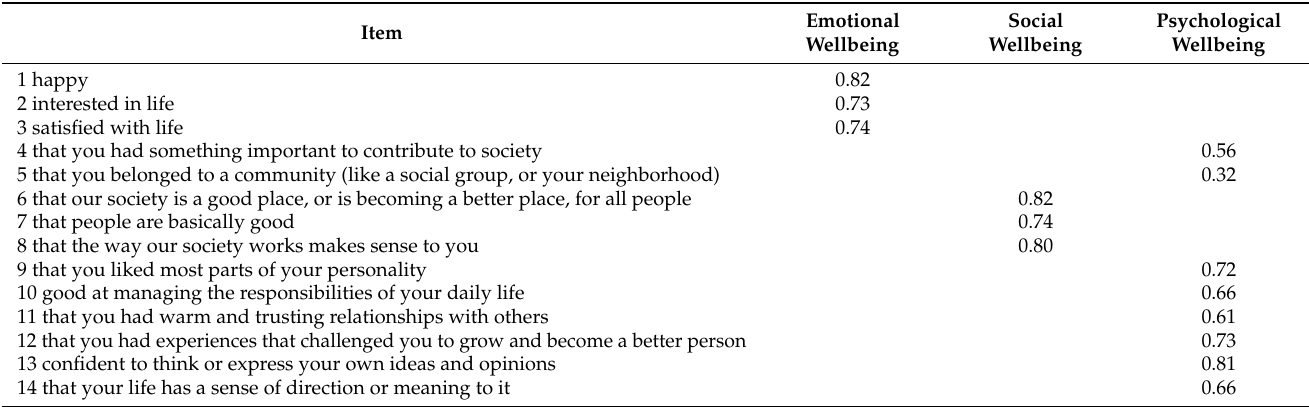
Table 2. Exploratory factor analysis pattern matrix results in random samples of participants ( n =